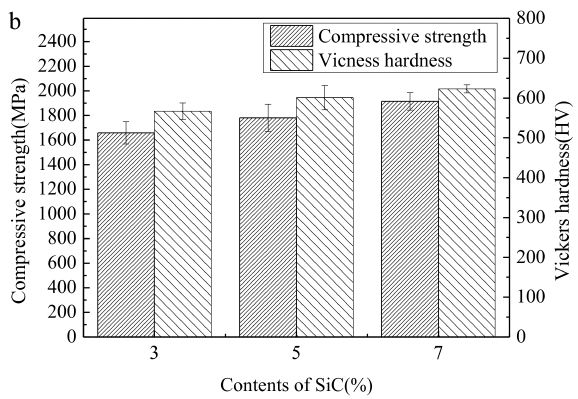
Figure 7. Room temperature mechanical properties of the new Nb matrix composites: ( a ) flexural strength and fracture toughness; ( b ) compressive strength and Vickers hardness.